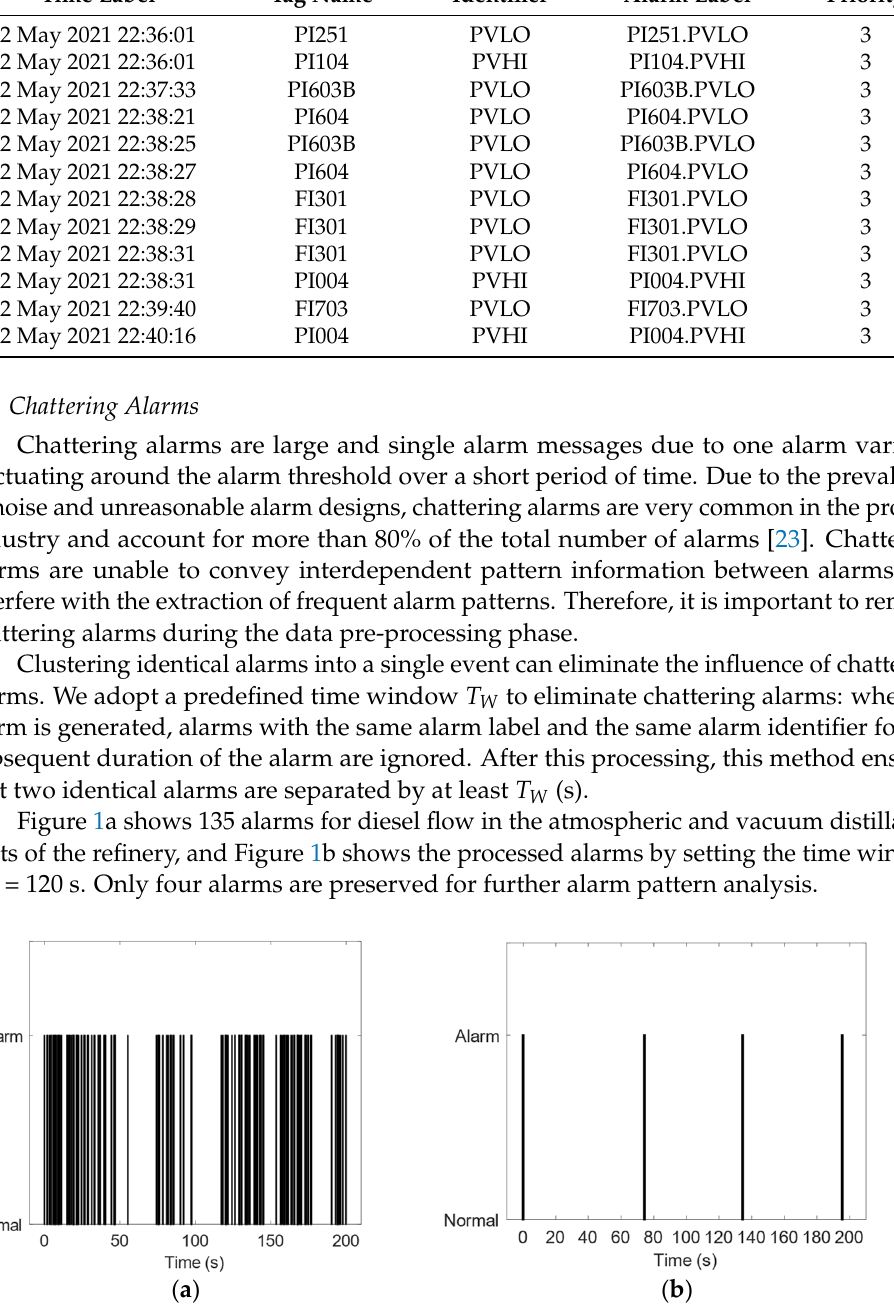
Figure 1. Alarm for tag “TI203.PVHI”. ( a ) Alarm “TI203.PVHI” before removing chattering alarms. ( b ) Alarm “TI203.PVHI” after removing cha tt ering alarms.